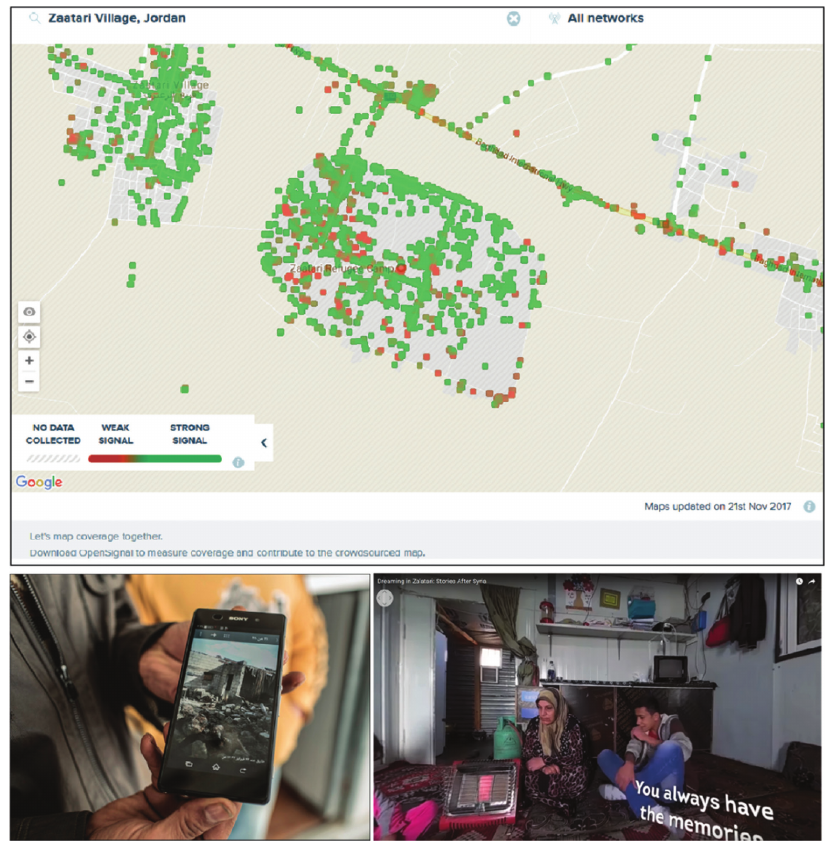
Figure 2: Top: cellular signals’ strength and density in Al-Zaatari Refugee Camp as reported by OpenSignal app users in the camp, 2017. Source: https://opensignal. com/networks. Bottom left: Still from the documentary film, “District Zero,” 2015. Source: www.districtzero.org/. The movie documents the role mobile devices play in connecting Al-Zaatari residents to their homelands. Bottom right: A still from the documentary shorts: Syria after Syria. Filmed by young refugees living in Al-Zaatari, the shorts depict life in the camp. The image above shows the interior of one of the shelter units, modified to accommodate the physical and psychological needs of families. Source: